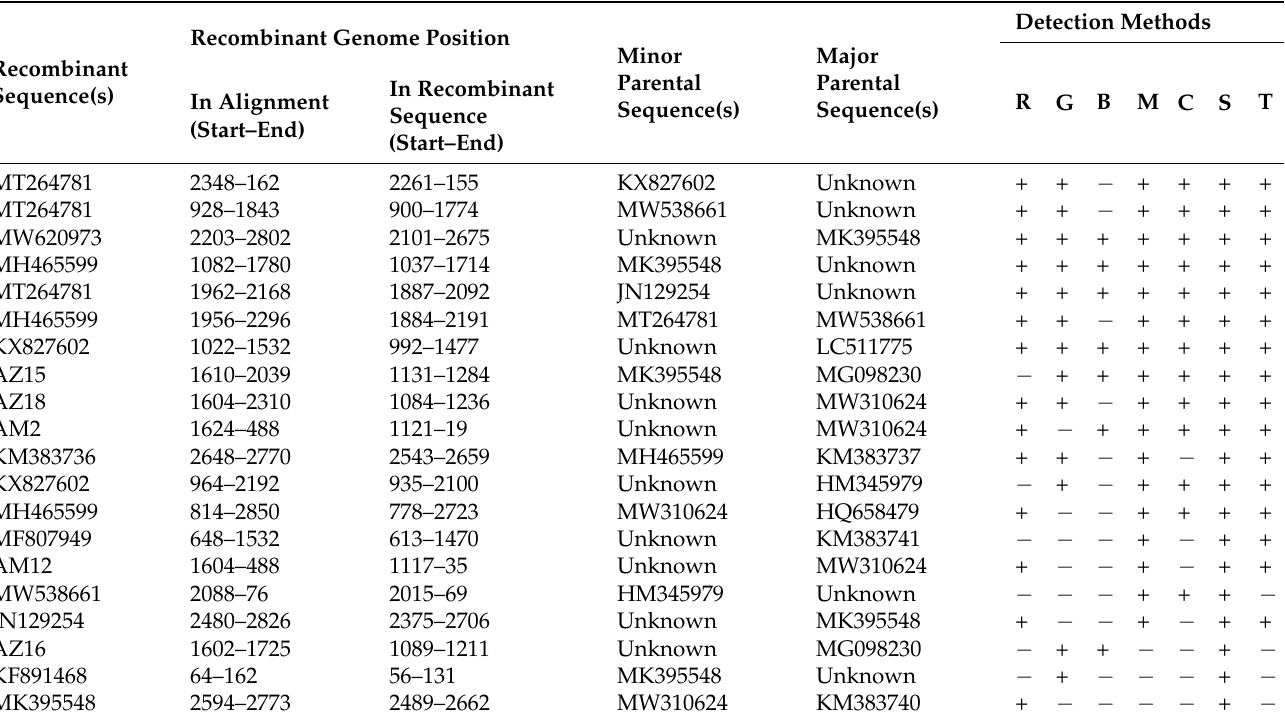
Table 3. Recombinant analysis